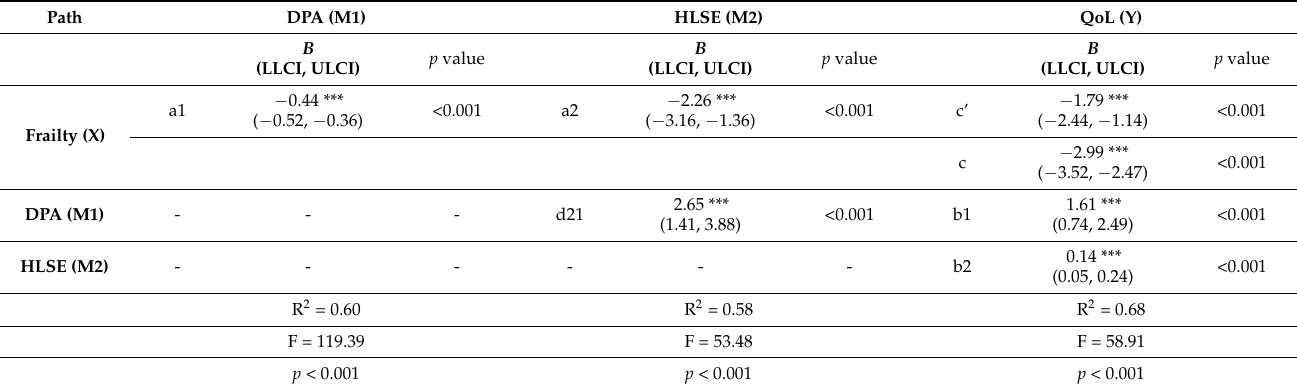
Table 3. Mediating effect of frailty on QoL through DPA and HLSE.